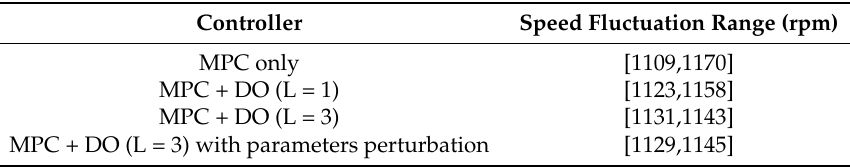
Figure 7. Speed synchronization performance with the proposed disturbance observer. ( a ) Speed synchronization performance; ( b ) Disturbances torque estimation results. Table 3. Speed fluctuation range of different disturbance observer gains.